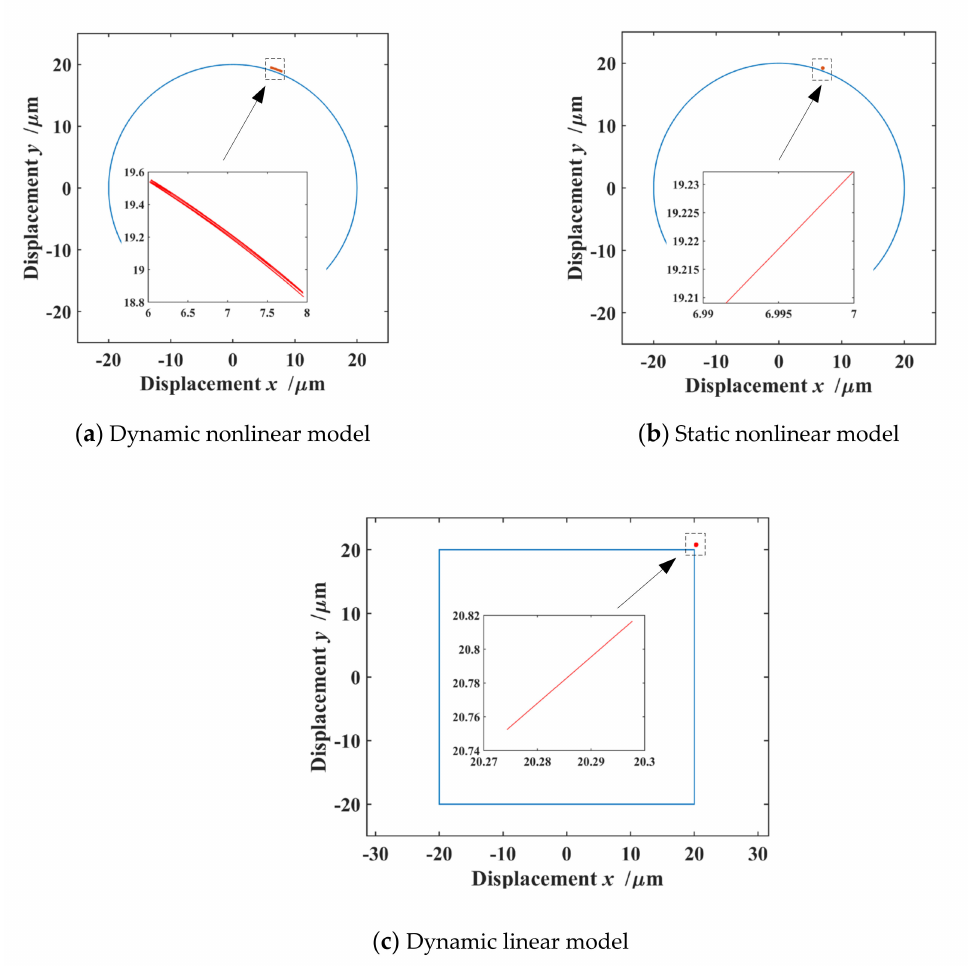
Figure 5. Trajectory of center of driven